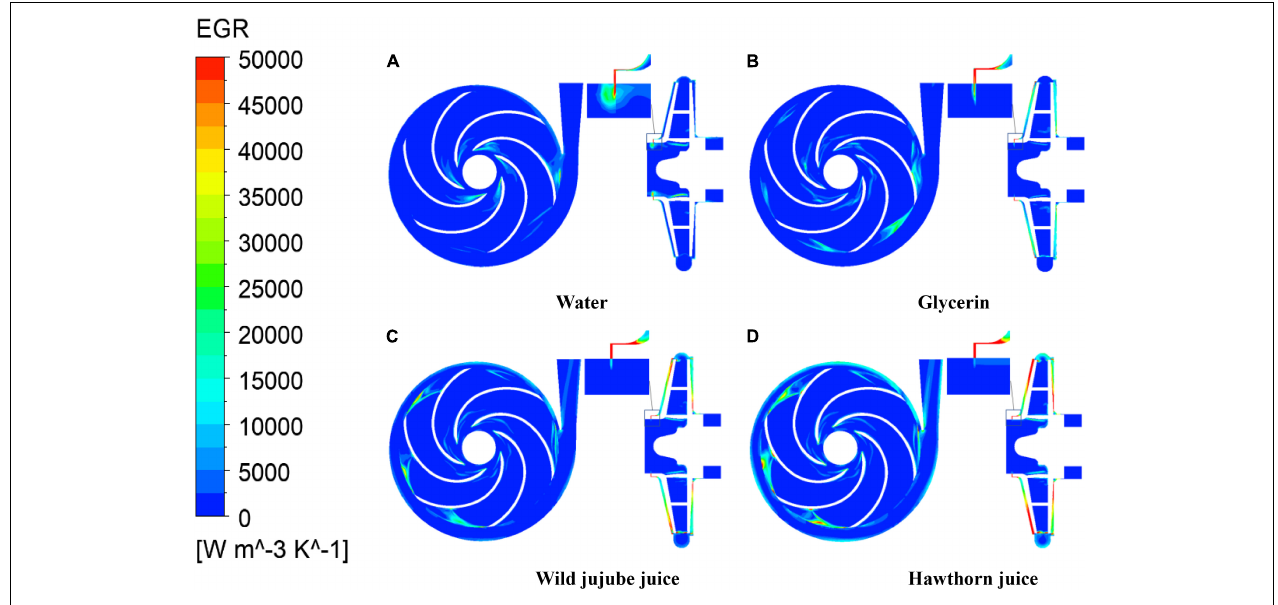
FIGURE 16 | Entropy production distribution of impeller and volute in the middle and y = 0 section. (A) Water, (B) Glycerin, (C) Wild jujube juice and (D) Hawthorn